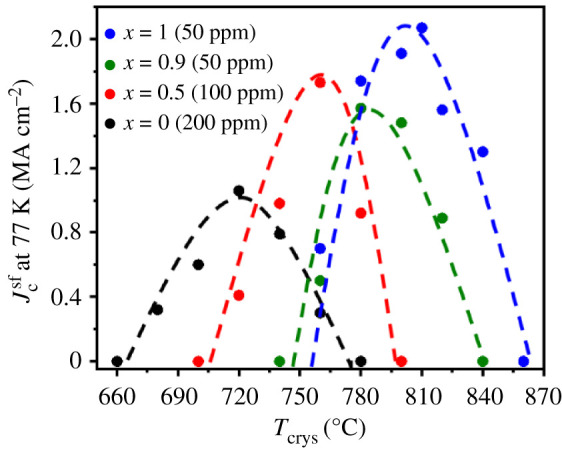
Dependence of Jcsf at 77 K on Tcrys for Yb1−xSmxBa2Cu3O7−δ films with x = 0, 0.5, 0.9 and 1 at their optimal pO2 value. The dashed lines are guides for the eyes.